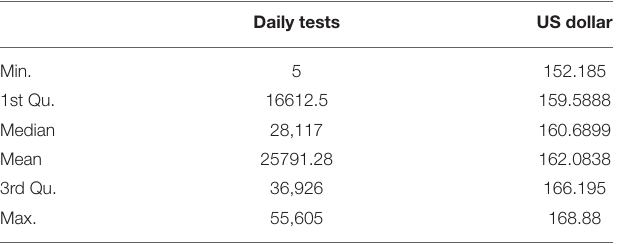
TABLE 10 | Summary statistics of daily tests and PKUSD dollar exchange